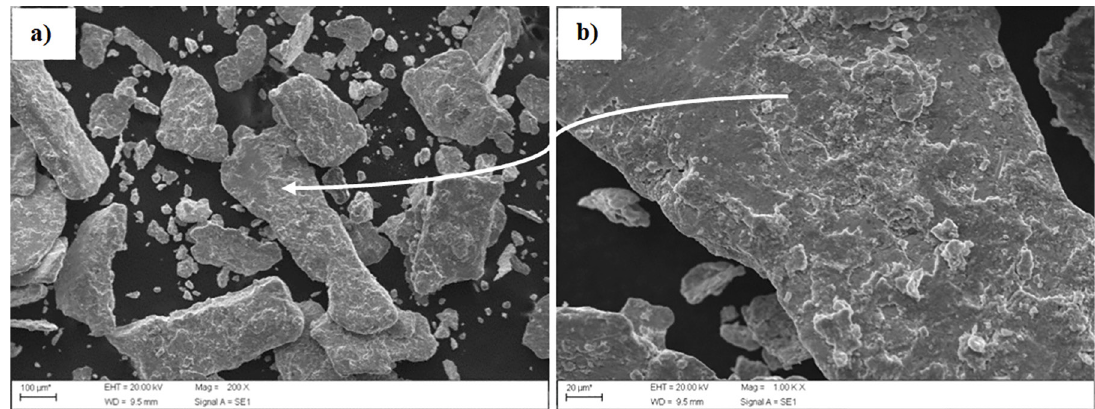
Figure 4. Aluminum bronze alloy milled for 50 hours beginning a spherical shape (a); morphology of lump produced (b). greater number of crystal planes in its structure, there is